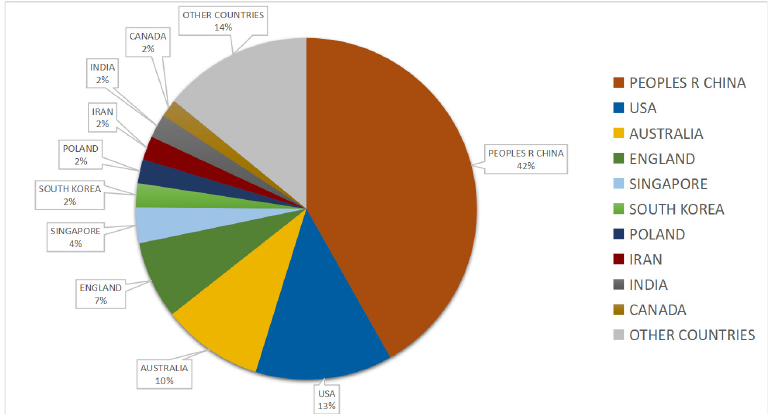
Figure 2. Distribution of countries (total number of articles: 119).